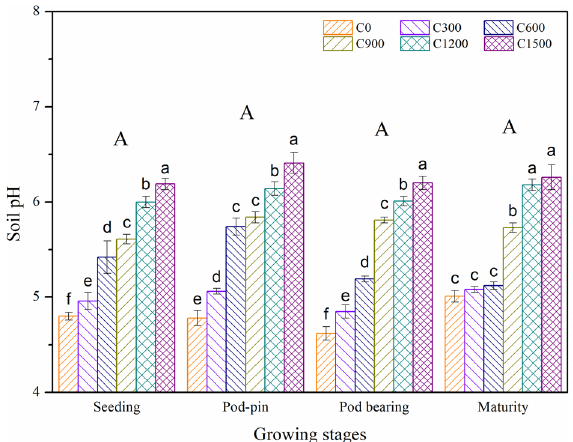
Figure 1. Effects of slaked lime application on soil pH values. The values are means (± SD) of three replicates. Bar groups with different capital letters indicate significant differences ( p < 0.05) among the growth stages. Bars with different lowercase letters indicate significant differences ( p < 0.05) among the six slaked lime treatments for the same growth stage.